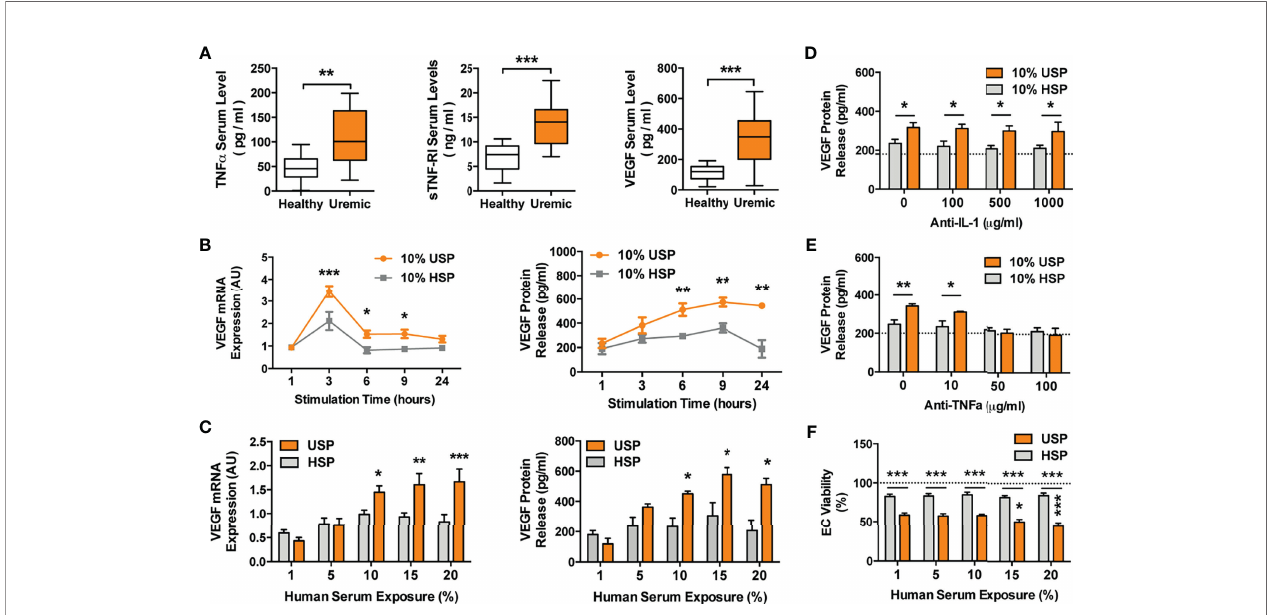
FIGURE 4 | Elevated TNF- a and VEGF levels in uremic serum and VEGF induction in ECs by uremic serum, but omission of VEGF induction by TNF- a blockade. (A) Levels of TNF- a (pg/ml), sTNF-R1 (ng/ml) and VEGF (pg/ml), in sera derived from healthy control subjects or uremic hemodialysis patients (n=14), used to generate the healthy and uremic serum pools (HSP and USP, respectively; Mann-Whitney test, Box plots min-max range); (B, C) Kinetics and dose-response of endothelial cell (EC) VEGF mRNA (AU; arbitrary units; n=6) and protein production (pg/ml) in response to incubation with HSP or USP (both 2way-ANOVA); (B) To assess kinetics of VEGF production, the ECs were incubated for different time points (1-24 hours) with 10% serum with the peak of VEGF mRNA expression detected at 3 hours and maximal protein expression at 6-24 hours; (C) To assess the dose-response of VEGF production the ECs were incubated with different concentrations of (1-20% serum) with maximal VEGF mRNA expression and protein secretion being detected in response to 10-20% serum after 3 and 24 hours of incubation respectively; and (D – F) The effect of either: (D) Anti-IL-1 receptor antagonist Anakinra, or (E) Anti-TNF- a blocking antibody In fl iximab, on human uremic serum-induced VEGF release in ECs. The cells were pre-treated with or without either Anakinra or In fl iximab for 1 hour, followed by stimulation for 24 hours with either 10% USP or 10% HSP (n=7), and ECs were subsequently assessed for VEGF release (both 2way-ANOVA); and (F) Dose-dependent effect of 1-20% USP vs . 1-20% HSP on EC viability, with assessment of EC viability (% viable cells, n = 6) with the WST-8 cell viability assay after 24-hour stimulation (2way-ANOVA). Box plots min-max range with Mann-Whitney-test, other plots 2way-ANOVA-testing with mean ± SEM, with * P < 0.05, ** P < 0.01, and *** P <